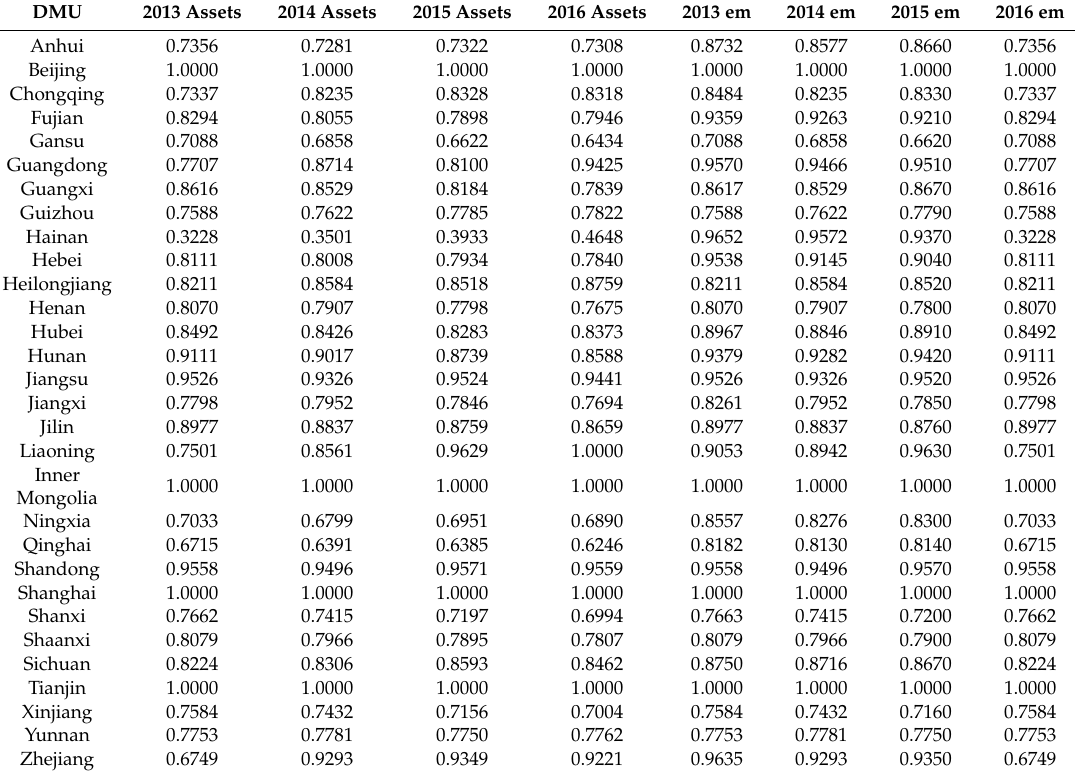
Table 8. 2013–2016 asset and employment (em) e ffi